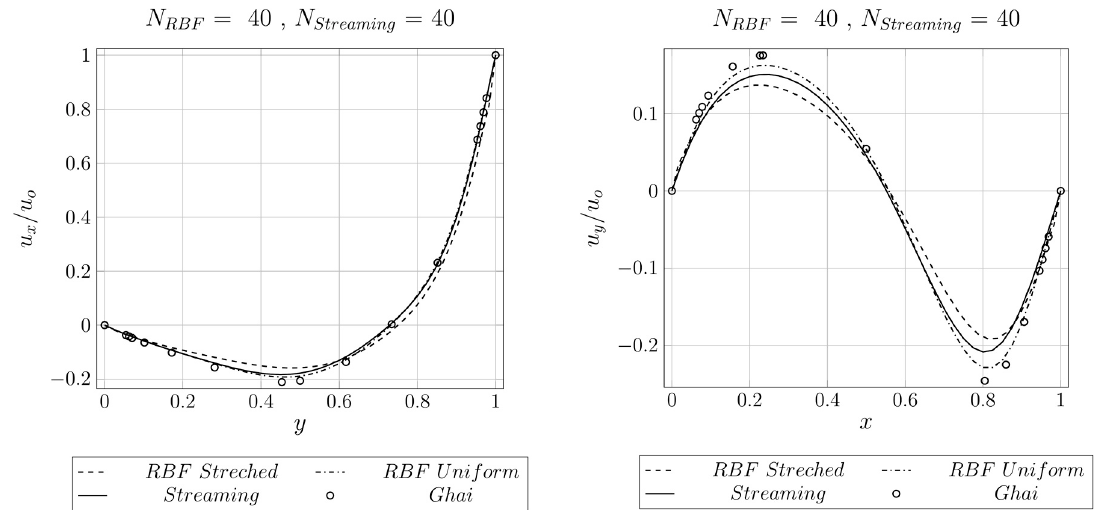
Figure 6. Lid ‐ driven cavity solved using streaming with 40 ‐ mesh and RBF interpolation with 40 ‐ Figure 6. Lid-driven cavity solved using streaming with 40-mesh and RBF interpolation with 40-mesh mesh uniform and stretched. uniform and